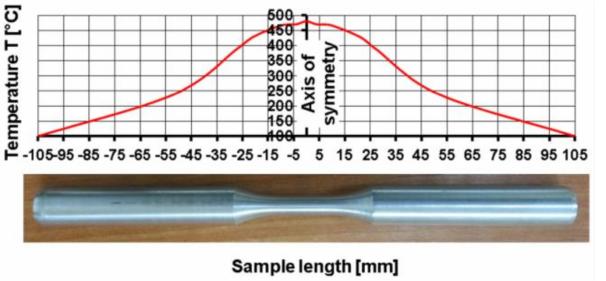
Figure 4. Actual temperature distribution along the sample’s length determined by the con- tact method.